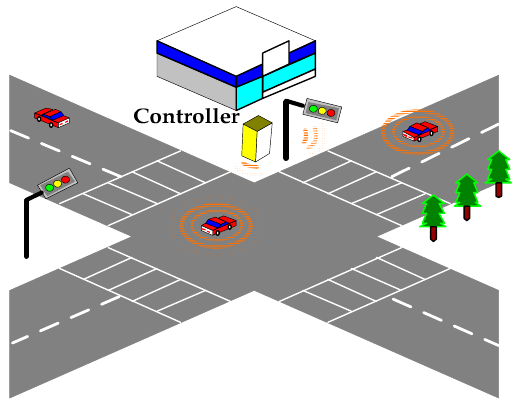
Figure 1. The schematic diagram of intersections between intersection and signal controller under Vehicle to Infrastructure (V2I).